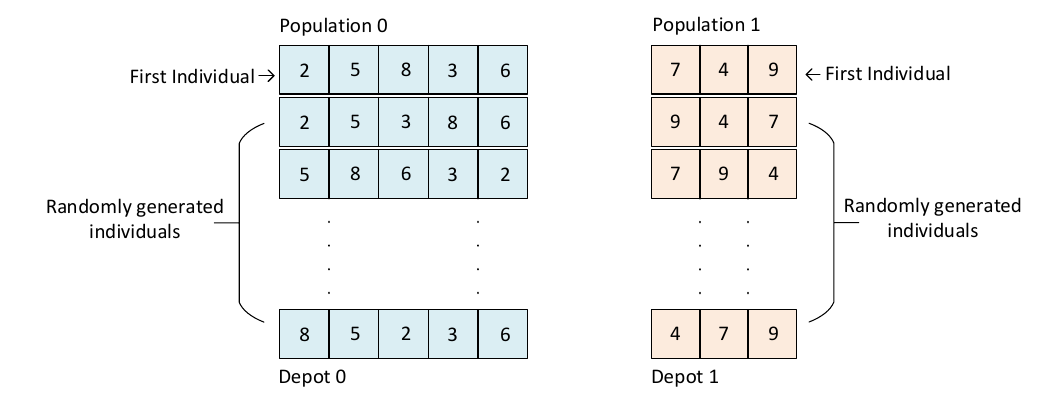
Fig. 3. Structure of the initial